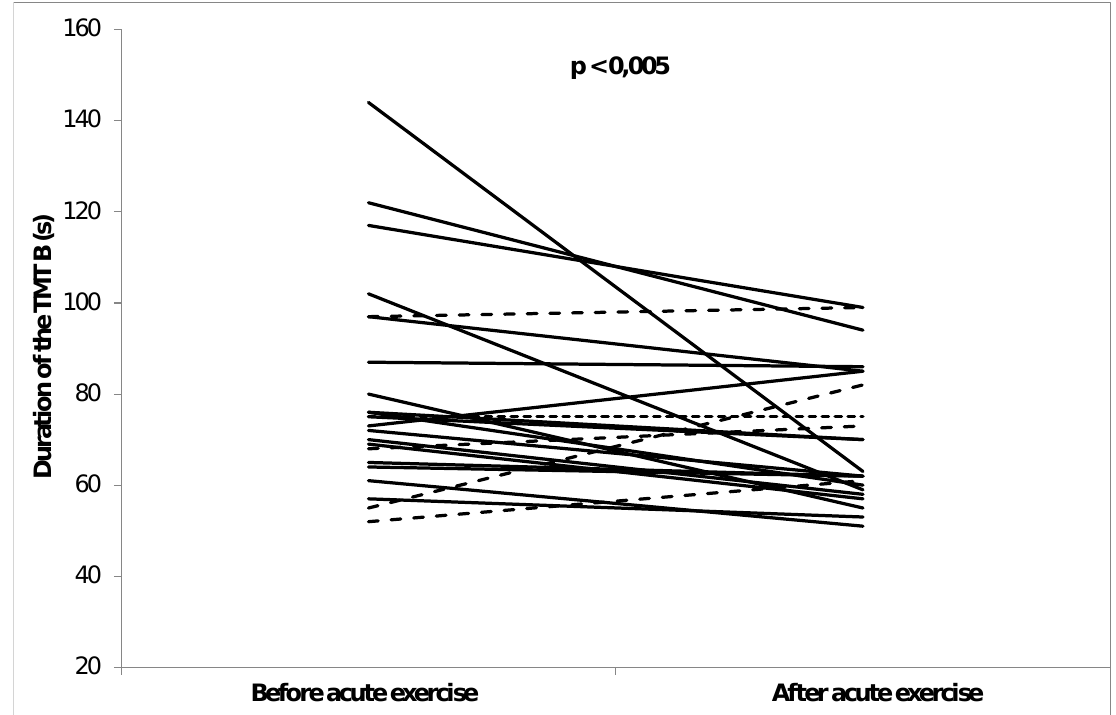
Fig.4. Individual scores in the Trial Making Test – duration of the TMT B phase. Each subject’s results from before and after acute exercise are connected by a line. Solid line depicts subjects who fared better on the post-exercise test, dashed lines those who fared worse, dotted lines represents individuals with score unchanged after acute physical